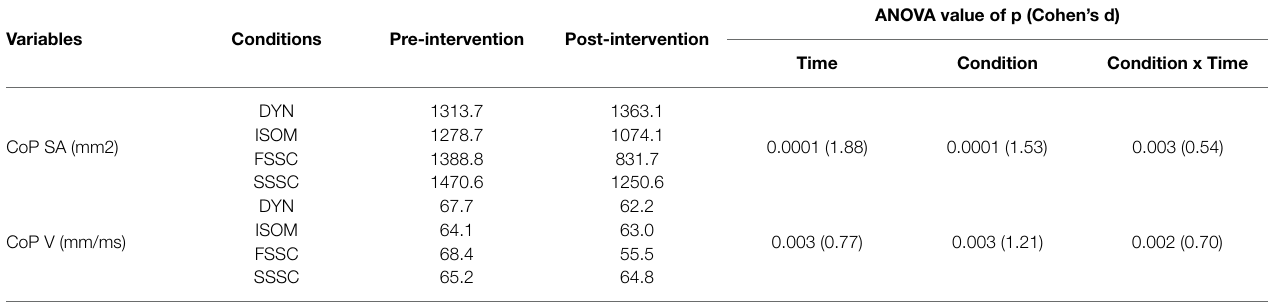
TABLE 3 | Results of the two-way ANOVA for repeated measures.